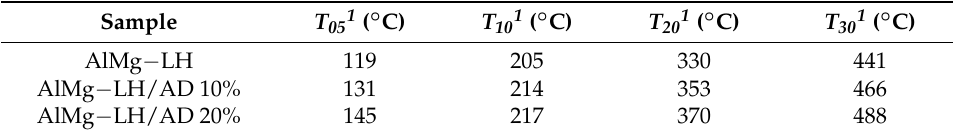
Table 2. Thermogravimetric analysis of AlMg − LH/AD pigments.